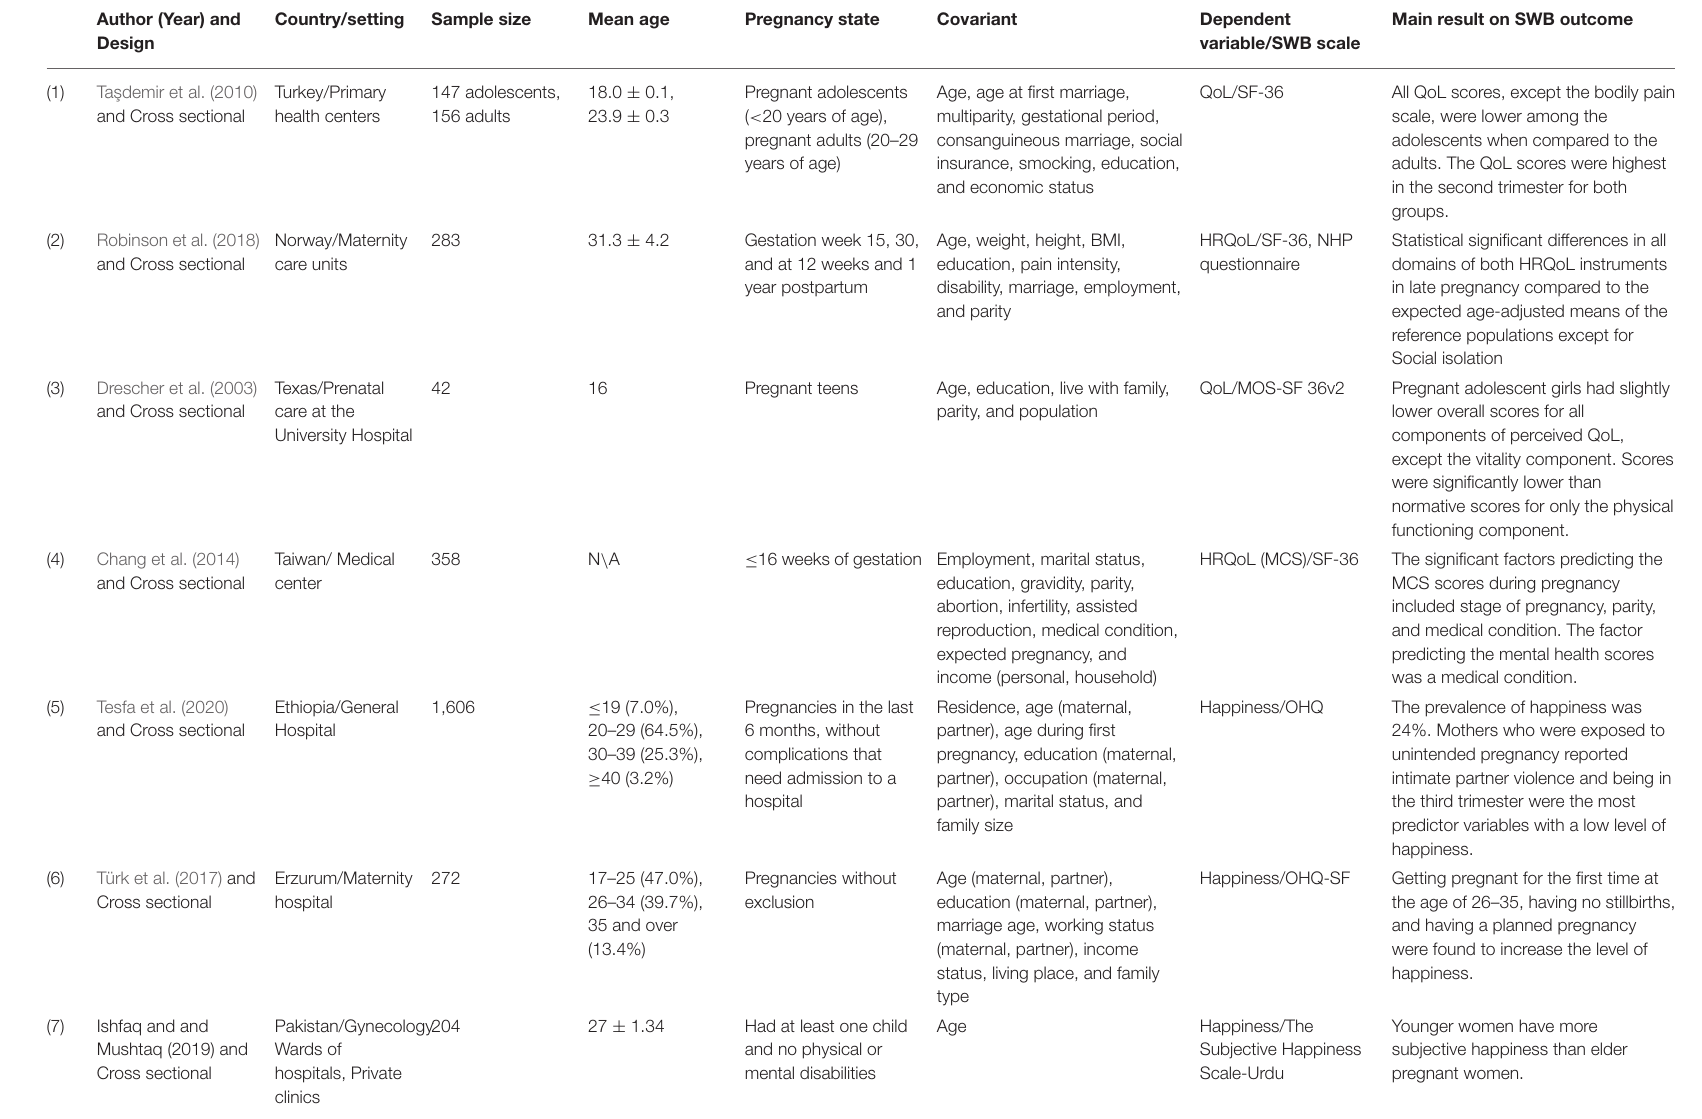
TABLE 2 | The effect of pregnancy on subjective well-being